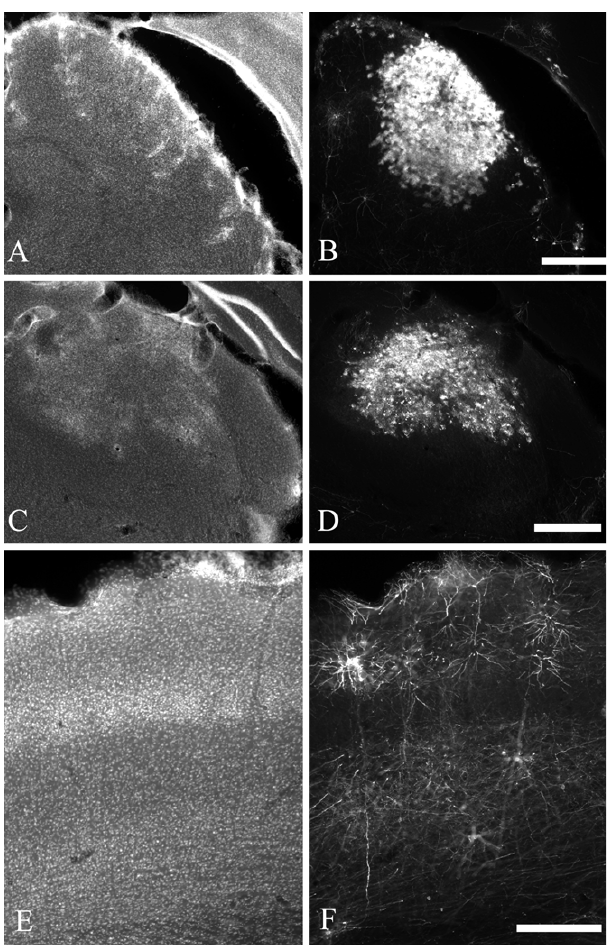
Figure 1. Photomicrographs illustrating examples of virus injection sites, visualized by immunohistochemistry for EGFP (B, D, F). The